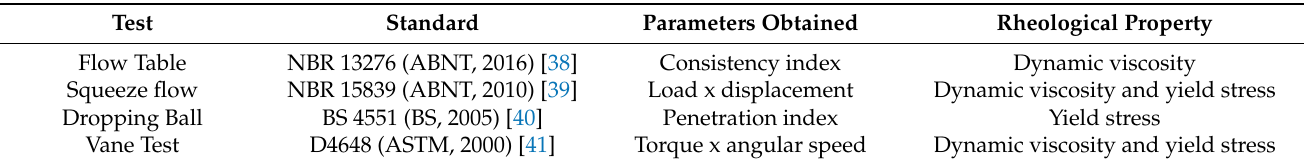
Table 1. Tests to obtain mortar workability